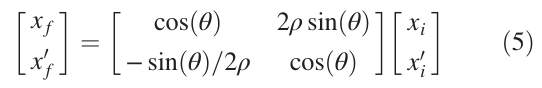
FIG. 1. A beam of chargedparticles travelingdown a conducting beam pipe generates image charge and image current. The image charge generates an electric field with a force acting to pull the beam away from the axis. The image current generates a magnetic force acting to pushthe beam toward the axis.When thebeam is off axis, these forces are asymmetric. The IDI is responsible for steering the beam centroid. The BBU instability is responsible for imprinting and amplifying oscillations in the